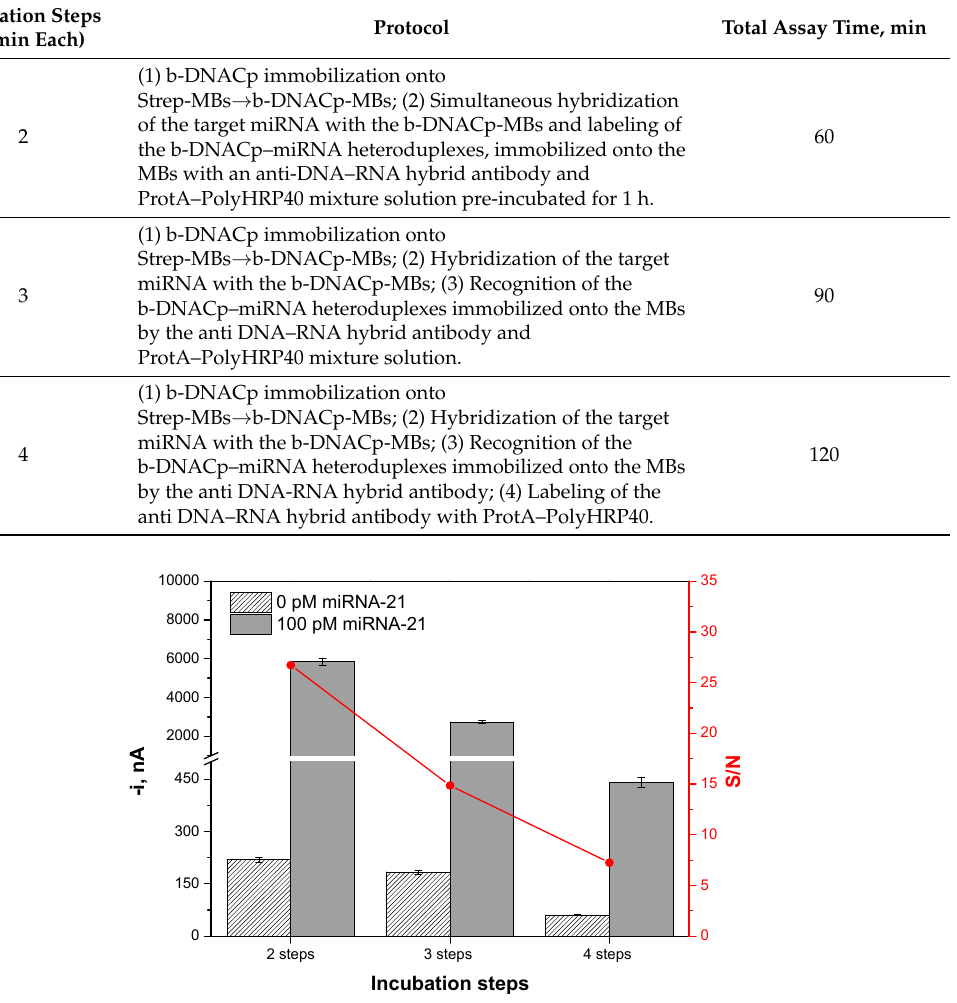
Table 2. Working protocols evaluated to prepare the amperometric biosensor for the determination of miRNA-21.